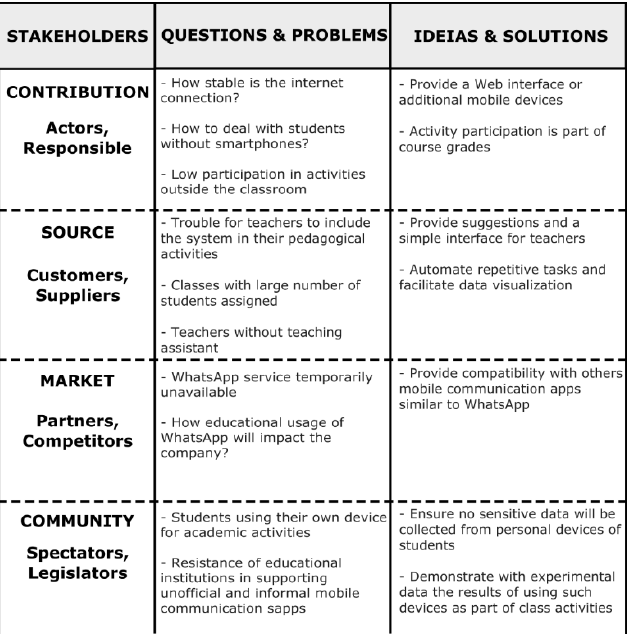
Fig 2. Evaluation Frame